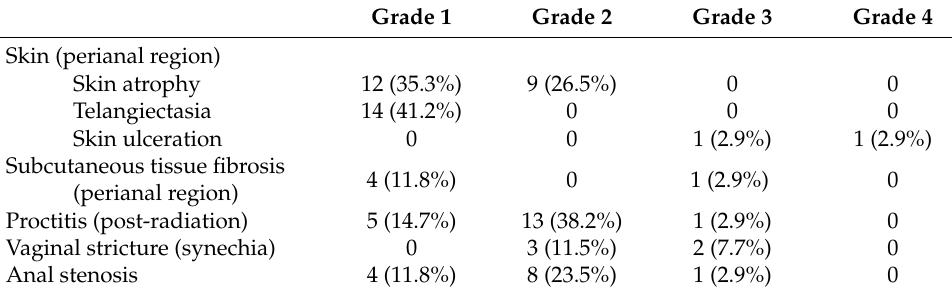
Table 5. Chronic toxicity (CTCAE version